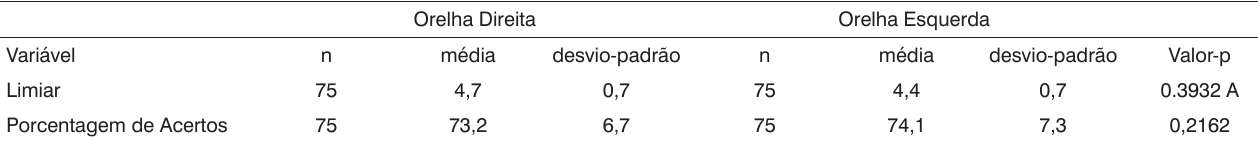
Tabela 3. Média, desvio padrão e p-valor para limiares de detecção de gap (em ms) e porcentagem de acertos na comparação entre orelha direita e esquerda.